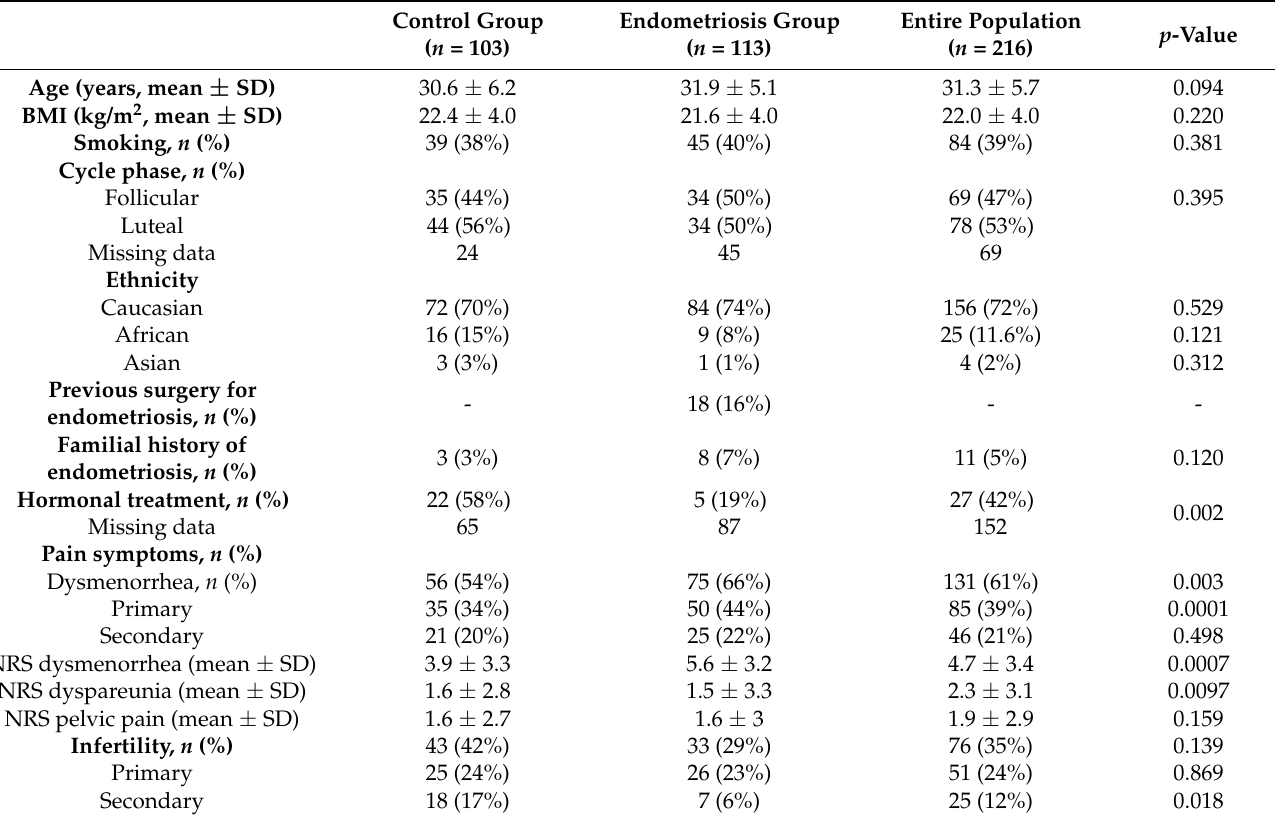
Table 1. Clinical characteristics of the study population. NRS: Numerical Rating Scale. BMI: body mass index. A t -test was used for a comparison of continuous variables and a chi-square test for categorical variables. SD: standard